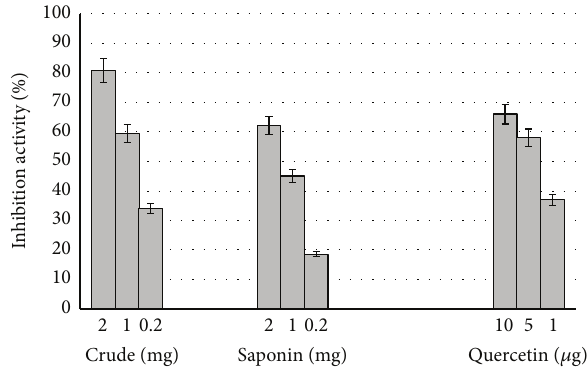
Figure 3: BCB antioxidant activity of crude and total saponin extracts from mother plant tuber of C. borivilianum .